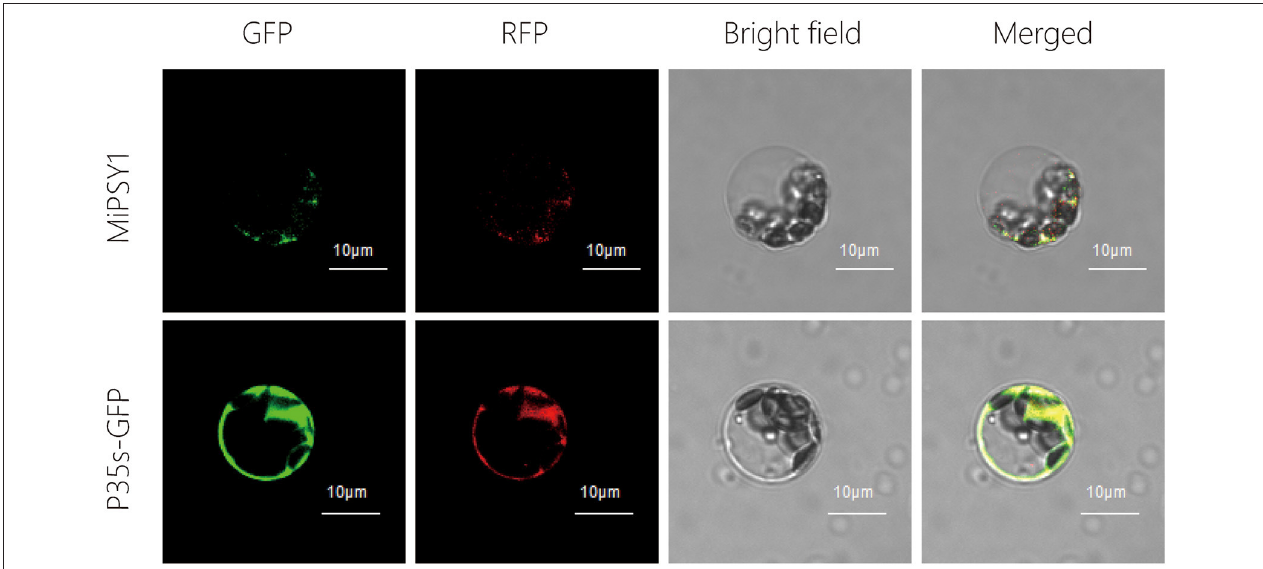
FIGURE 5 | Subcellular location of MiPSY1 protein in Arabidopsis protoplasts. Red fluorescent protein (RFP) was included in each transfection to serve as mitochondria localization. Bars = 10 µ m.